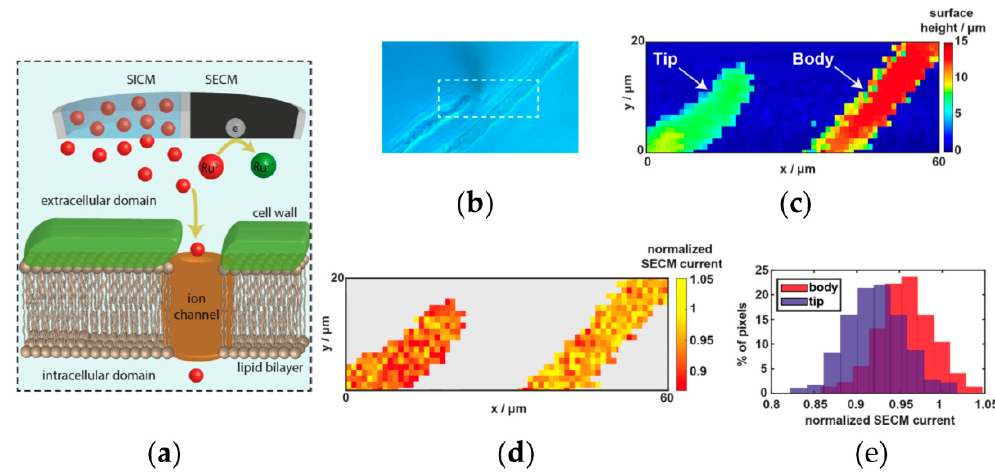
Figure 4. A dual barrel SECM-SICM probe is used to visualize molecular ([Ru(NH 3 ) 6 ] 3+ ) delivery and uptake at two regions of a single Zea mays root hair cell. ( a ) Schematic of the SECM-SICM setup, showing the probe positioned over a cell, in which [Ru(NH 3 ) 6 ] 3+ (Ru 3+ ) can diffuse/migrate from the delivering SICM barrel to the cell wall. Simultaneous measurement of ([Ru(NH 3 ) 6 ] 3+ ) reduction at the SECM electrode surface is made during the approach to the surface. This is compared to bulk (steady-state) current measurement for quantification. ( b ) Optical microscope image of the root hair cell. The dashed line marks the scanned area. ( c ) Topography image using the z-position at the end of each normal approach curve. ( d ) SECM current image over the sample, normalized to a bulk measurement at each pixel (current at the start of each normal approach curve). ( e ) Histogram plots of the normalized SECM current at each of the two regions of the root hair cell, labelled as “tip” and ”body” in part ( c ). (Adapted with permission from Reference [69]. Copyright (2017) American Chemical Society).